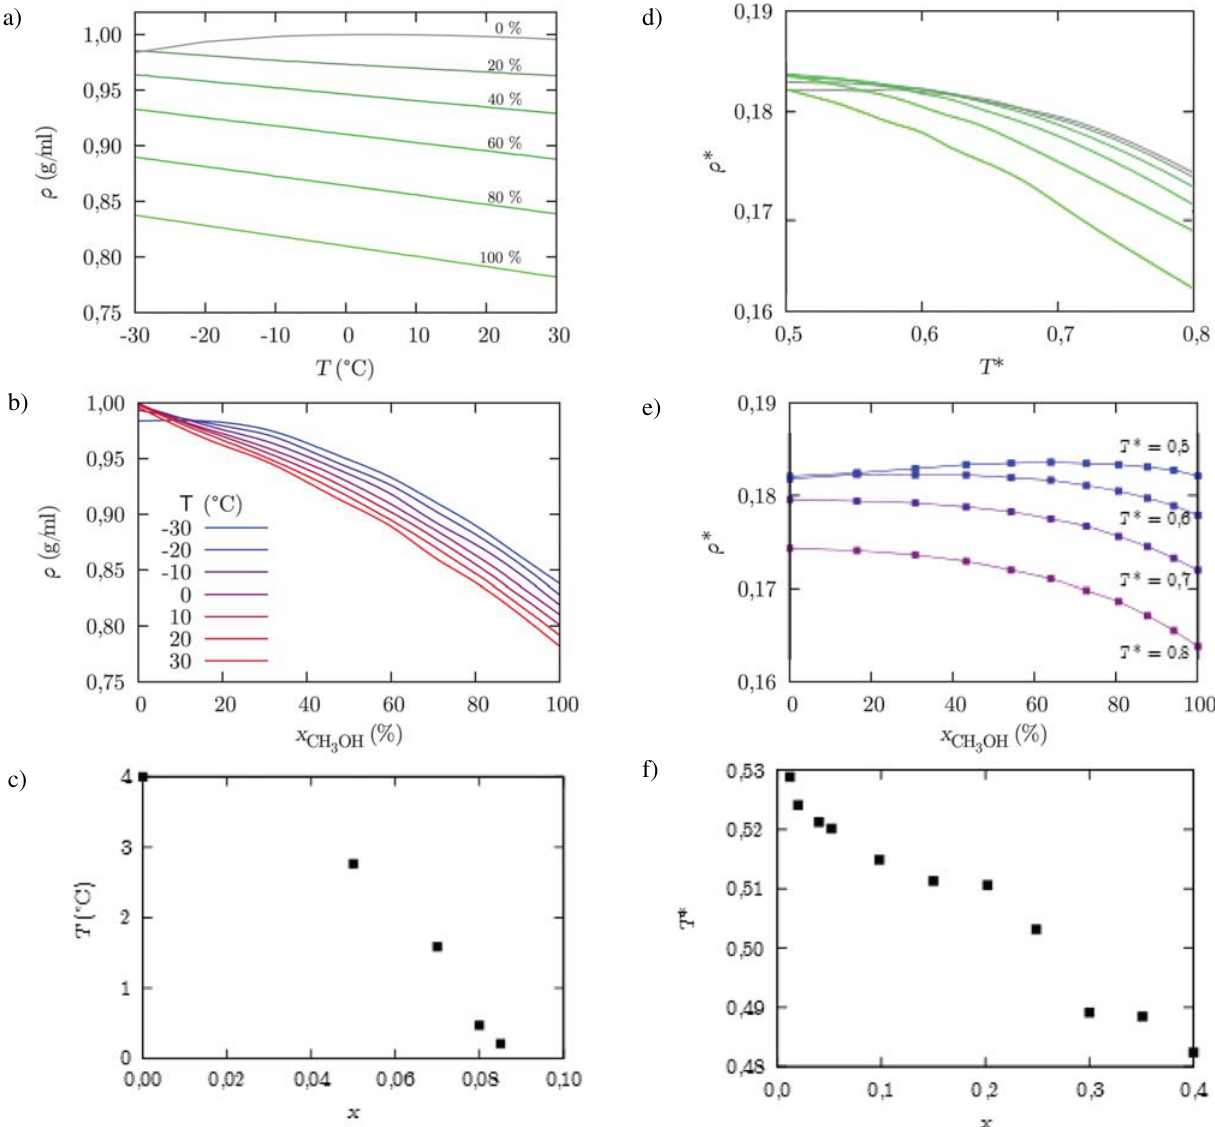
Figure 5: Density of methanol/water mixtures at 1 atm as a function of temperature and composition (mass fraction of methanol), and the tempe- rature of maximum density. Experimental results (panels a–c) and model results (panels d–f) show the same trends.